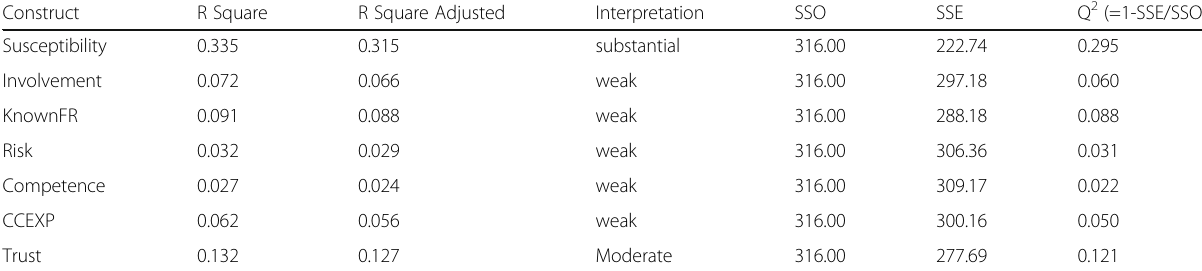
Table 8 Coefficient of determination ( R 2 ) and predictive relevance (Q 2 )